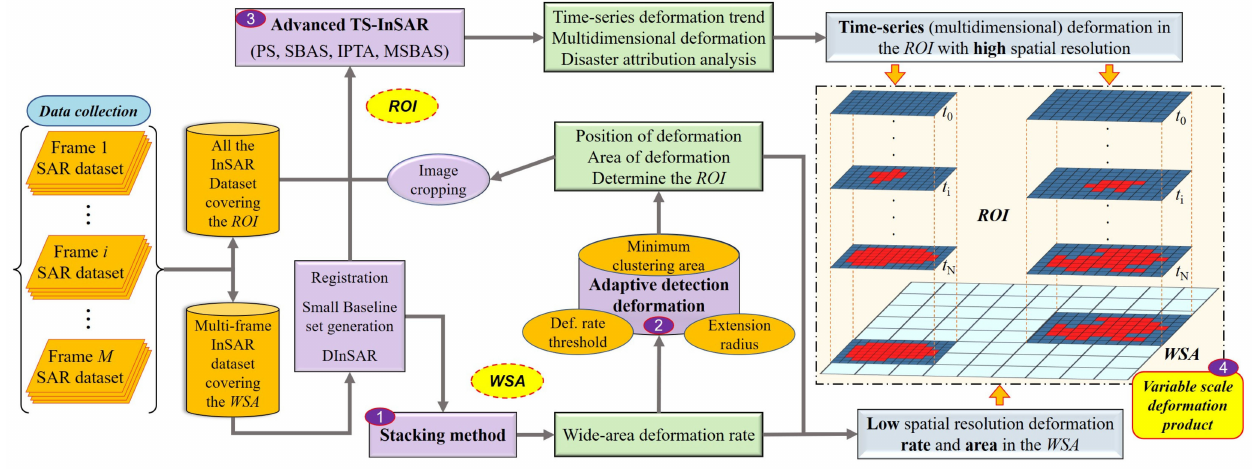
Figure 1. Flowchart of the method for the variable-scale monitoring of deformation in a wide